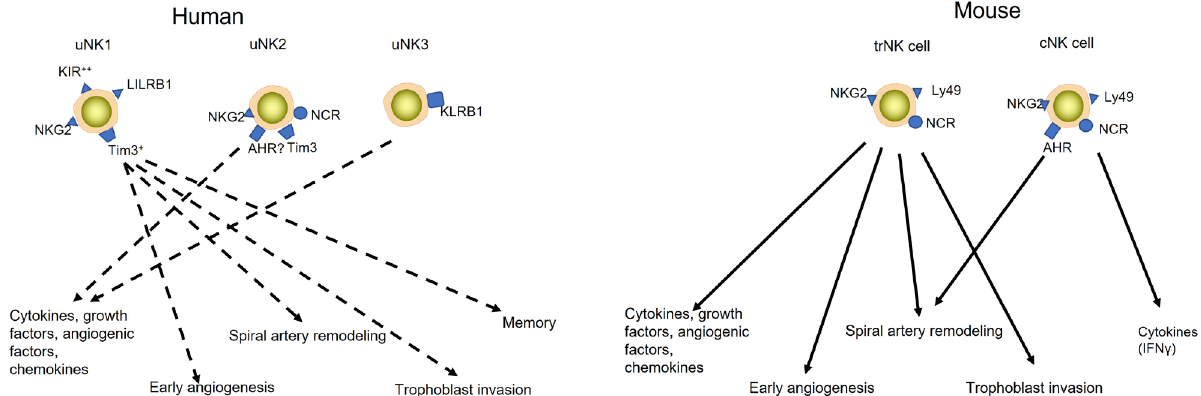
Figure 3. uNK cells subsets in humans (left) and mice (right). Humans have three uNK cell subsets: uNK1, uNK2, and uNK3. Although current knowledge indicates that human uNK cells are involved in decidual angiogenesis, trophoblast invasion and spiral artery remodelling, which subsets execute which function is not completely known. Therefore, dashed lines indicate which uNK cell subset may be involved in which function. Mouse uNK cells consist of two subsets, trNK and cNK cells. Various studies have shown that trNK cells are involved in decidual angiogenesis, trophoblast invasion and spiral artery remodelling, while cNK cells produce IFNγ, which is involved in spiral artery remodelling (indicated by uninterrupted lines). At this time uNK subsets have not been studied in the rat. KIR: killer-cell immunoglobulin-like receptor; NKG2: NK group 2; AHR: aryl hydrocarbon receptor; Tim3: T cell immunoglobulin and mucin domain-containing protein 3; NCR: natural cytotoxicity receptor; LILRB1: leukocyte immunoglobulin-like receptor B1; KLRB1: killer cell lectin-like receptor B1; ?: it is not sure that this receptor is expressed on these